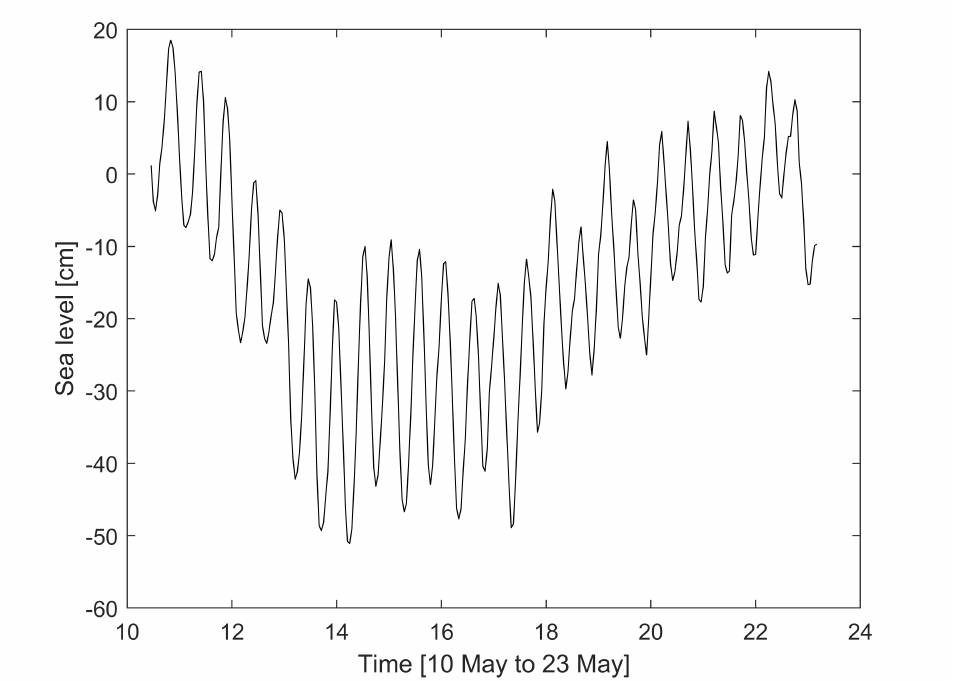
Figure 2. Water level variations for the period of the experiment. Data obtained from Sveriges meteorologiska och hydrologiska institut’s measurement station Brofjorden (id:35109) located 16 km from the test site. Data are measured